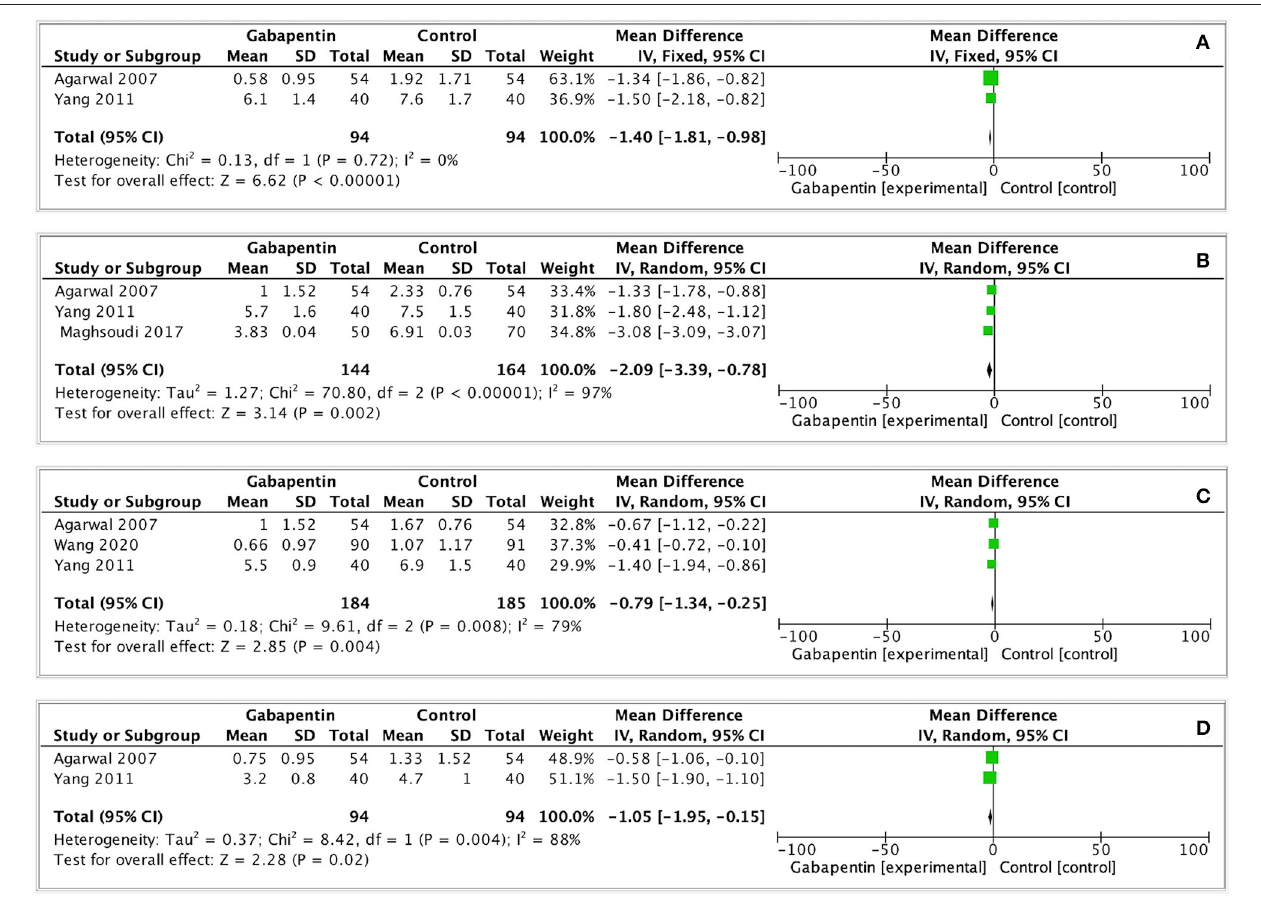
FIGURE 5 | Forest plot of postoperative pain scores. (A) Postoperative pain scores at 0h after surgery; (B) Postoperative pain scores at 1h after surgery; (C) Postoperative pain scores at 2h after surgery; (D) Postoperative pain scores at 6h after